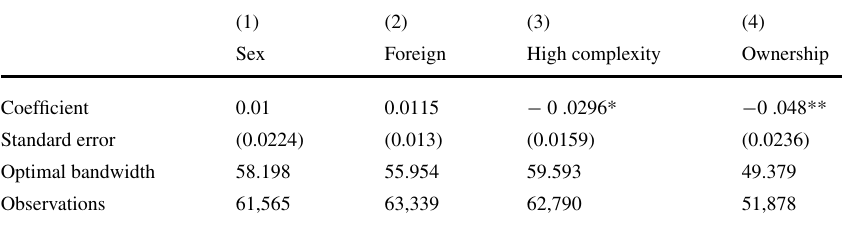
Table 4 Diff-in-disc continuity